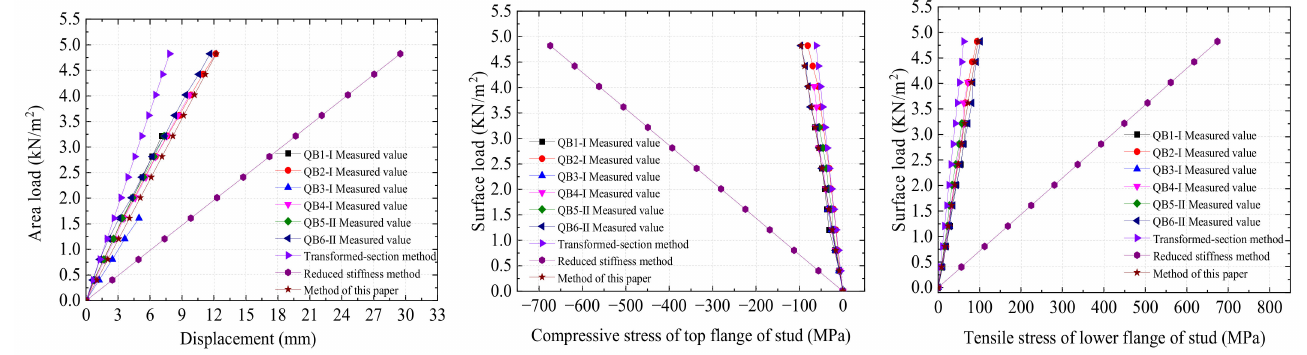
Figure 21. Comparison between theoretical calculation and actual